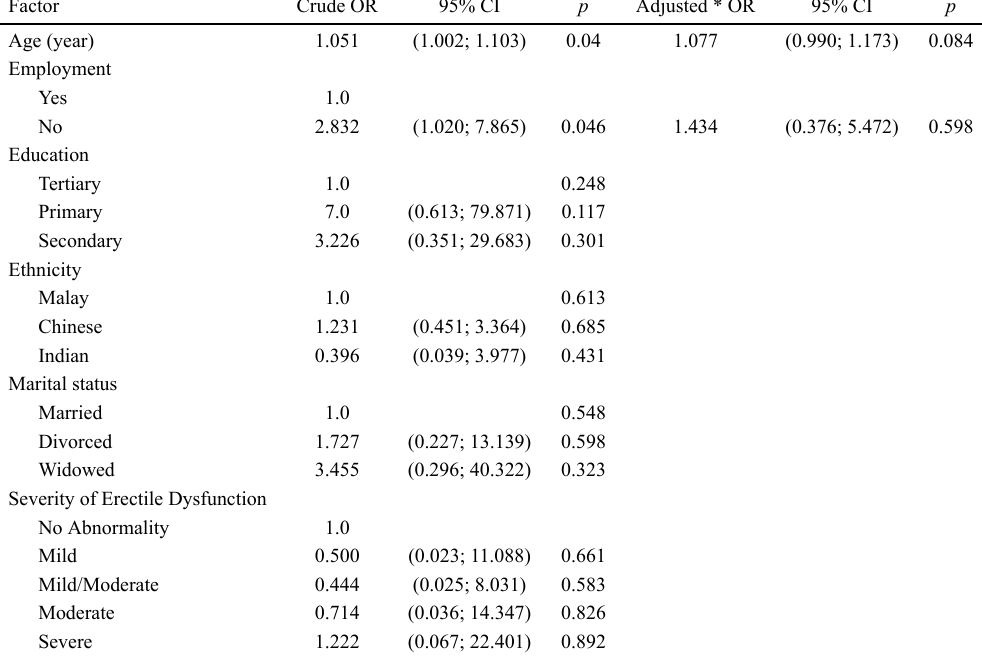
Table 3a. Factors associated with option to discuss or not about erectile dysfunction.